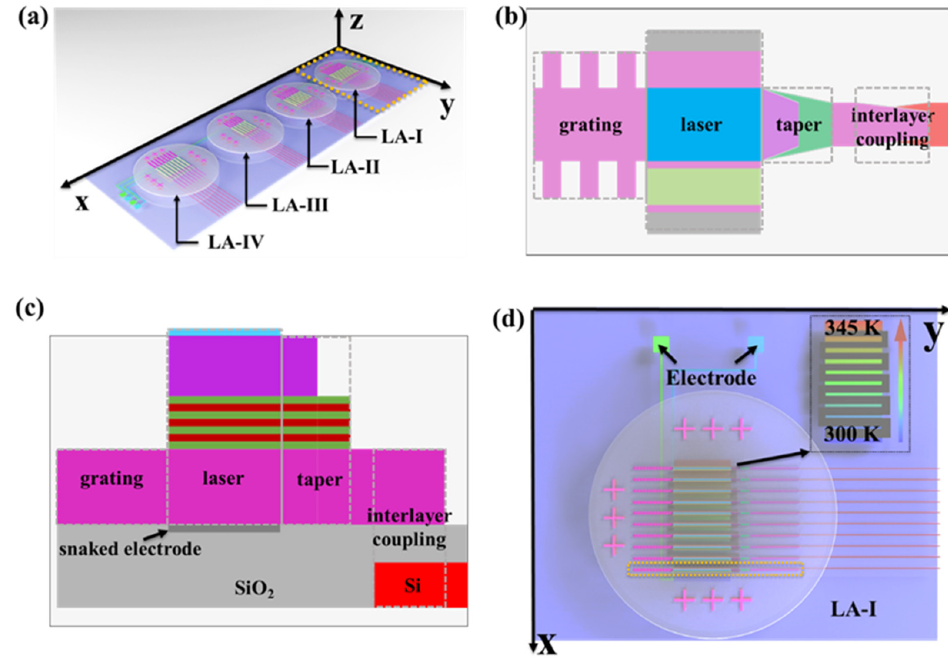
Figure 2. The structure of integrated laser arrays on the chip. ( a ) The overall structure of laser arrays. ( b ) The top view of the F-P MQW laser. ( c ) The cross-section of the F-P MQW laser. ( d ) The temperature-control electrode layout scheme of